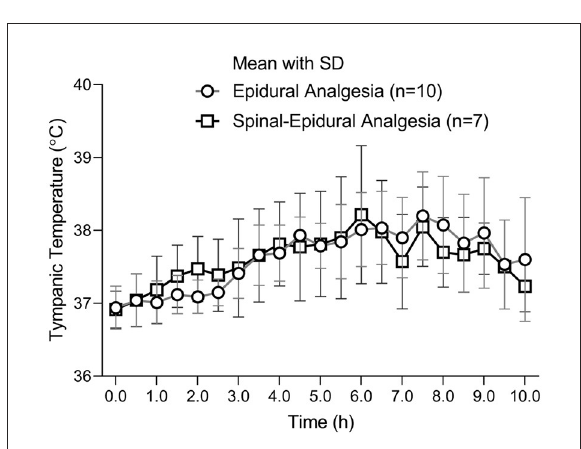
FIGURE2 The tympanic temperature changes over time.